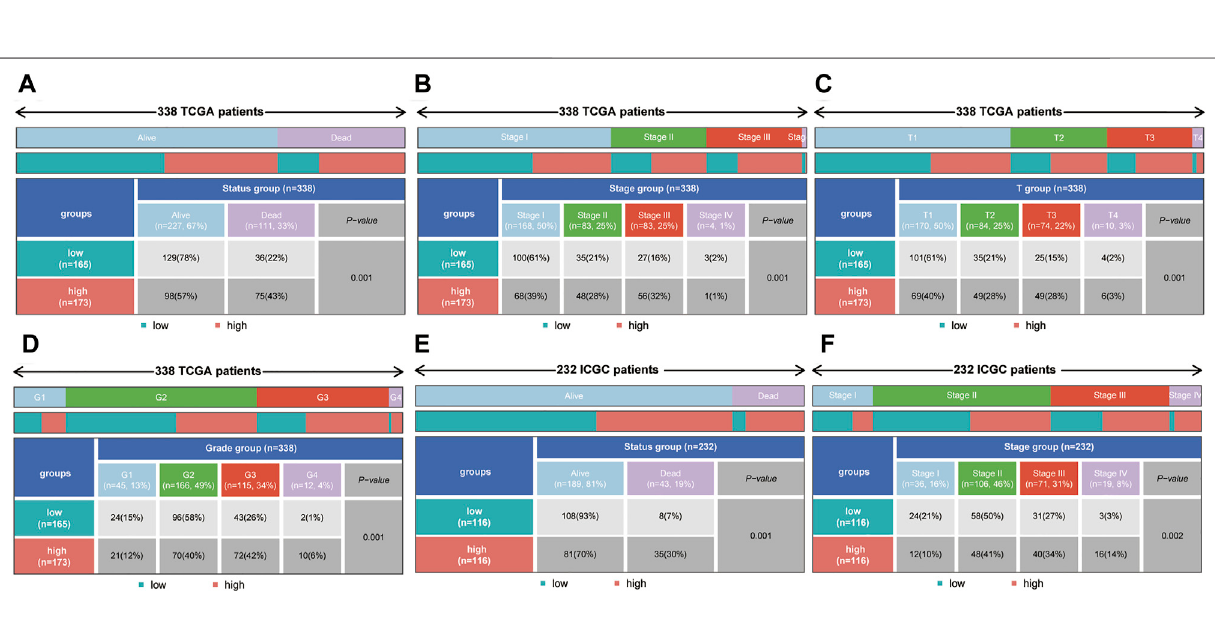
FIGURE 7 | The correlation between the risk score and mortality (or pathological stage) in the training set and validation set. (A – D) The high-risk group had higher mortality, more advanced pathological stage, a higher T stage and a higher tumor grade in the training set. (E,F) The high-risk group had higher mortality and more advanced pathological stage in the validation